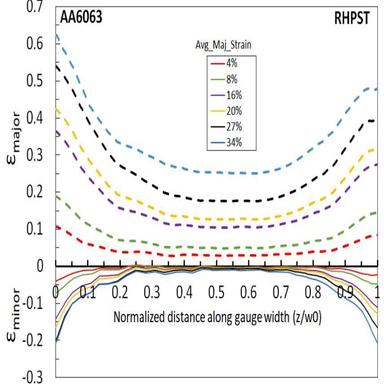
Evolution of the major strain and minor strain measured with DIC across the centerline of the gauge zone of the RHPST specimen at different average major strain measured in the center of the gauge.